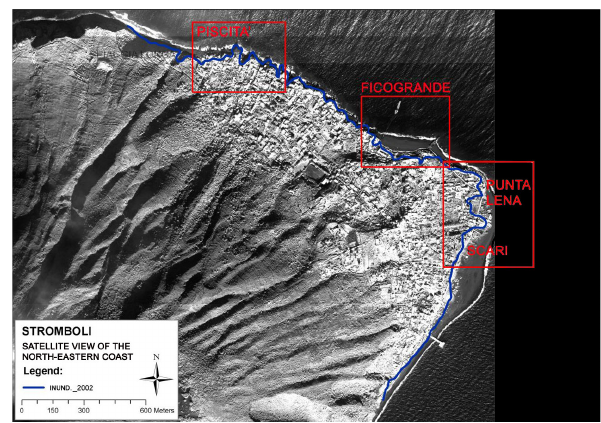
Fig. 2. A “Worldview” satellite image of the north-eastern coast of Stromboli Island. Main administrative divisions are highlighted with red frames. The blue line marks the limit of maximum inun- dation caused by the 2002